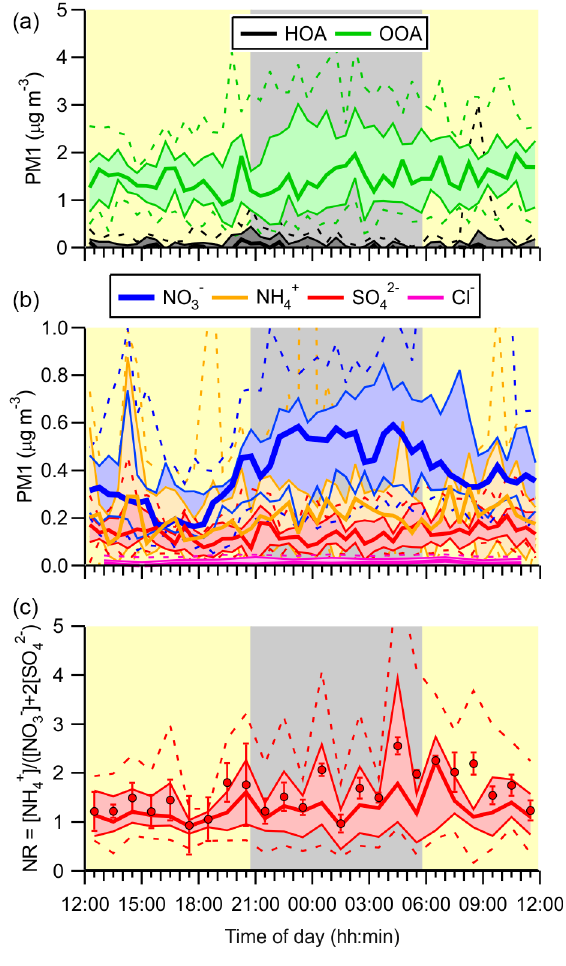
Figure 6. Diurnal averages of submicron (PM 1 ) ACSM data. (a) Organic aerosol displayed as hydrocarbon-like organic aerosol (HOA) and oxygenated organic aerosol (OOA) factors. (b) Inor- ganic aerosol fractions. (c) Neutralization ratio (NR).